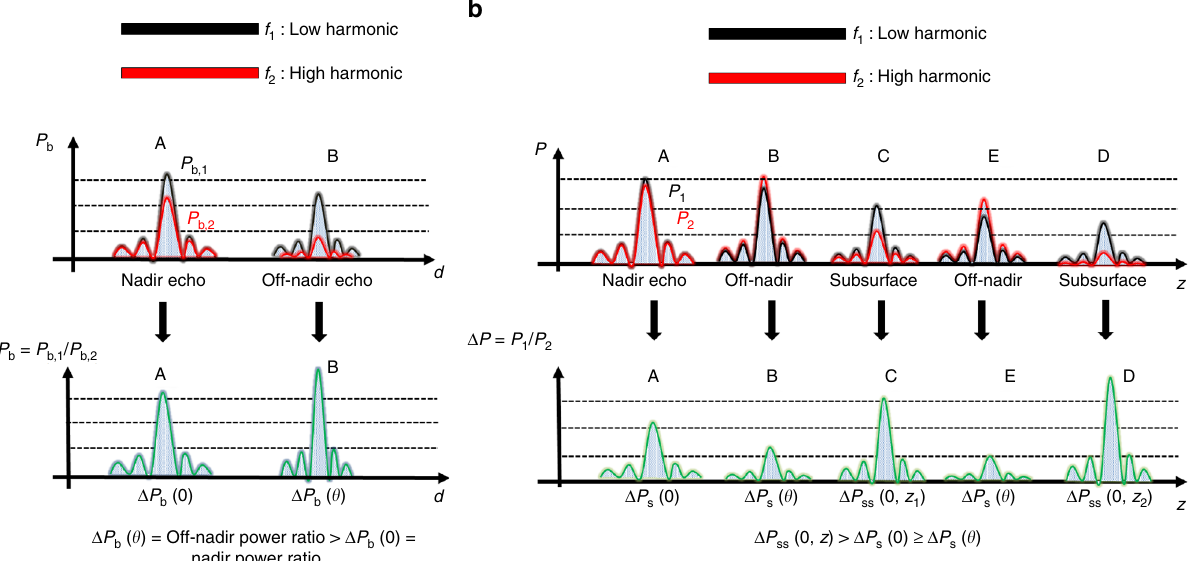
Fig. 5 Bats and radar sounder disambiguation strategy. Visual examples on how bats and radar sounders are able to disambiguate clutter on the power return at different harmonics. a For the bat case, P b,1 and P b,2 are the echo power received as a function of the distance at the two different harmonics. Points A and B are referred to Fig. 4a. b For the radar sounder case, P 1 and P 2 are the echo power received as a function of the distance at two different harmonics. Points A to E are referred to Fig. 4b